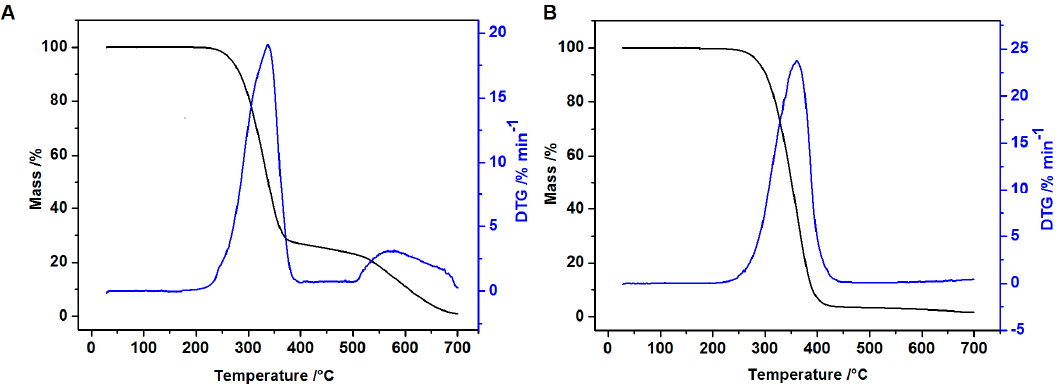
Figure 9. TG and DTG curves of D2AAK1_3 recording during thermal analysis with heating rate 20 °C min − 1 in air ( A ) and N 2 ( B ) atmospheres.